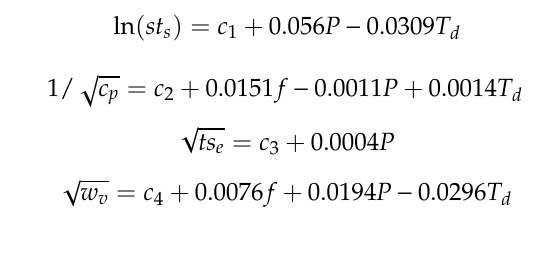
Table 3. Response surface method—ANOVA results.